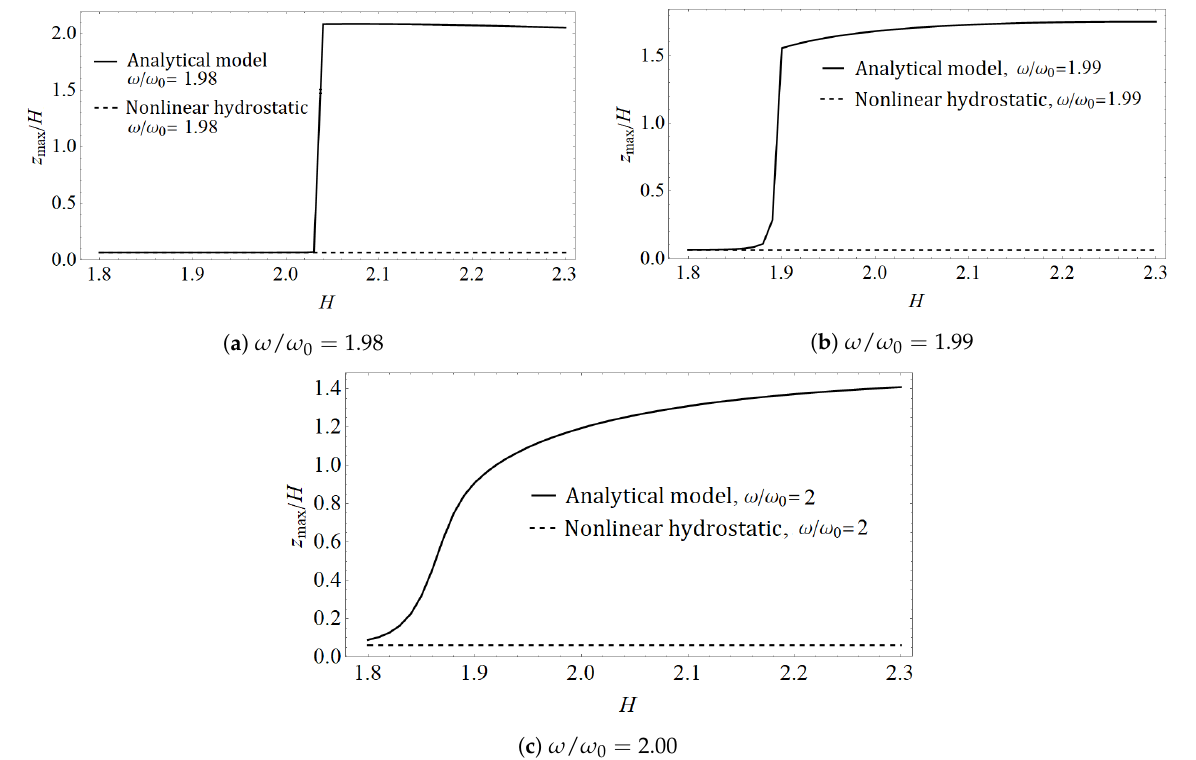
Figure 12. The normalised amplitude of the buoy oscillations as a function of wave amplitude.